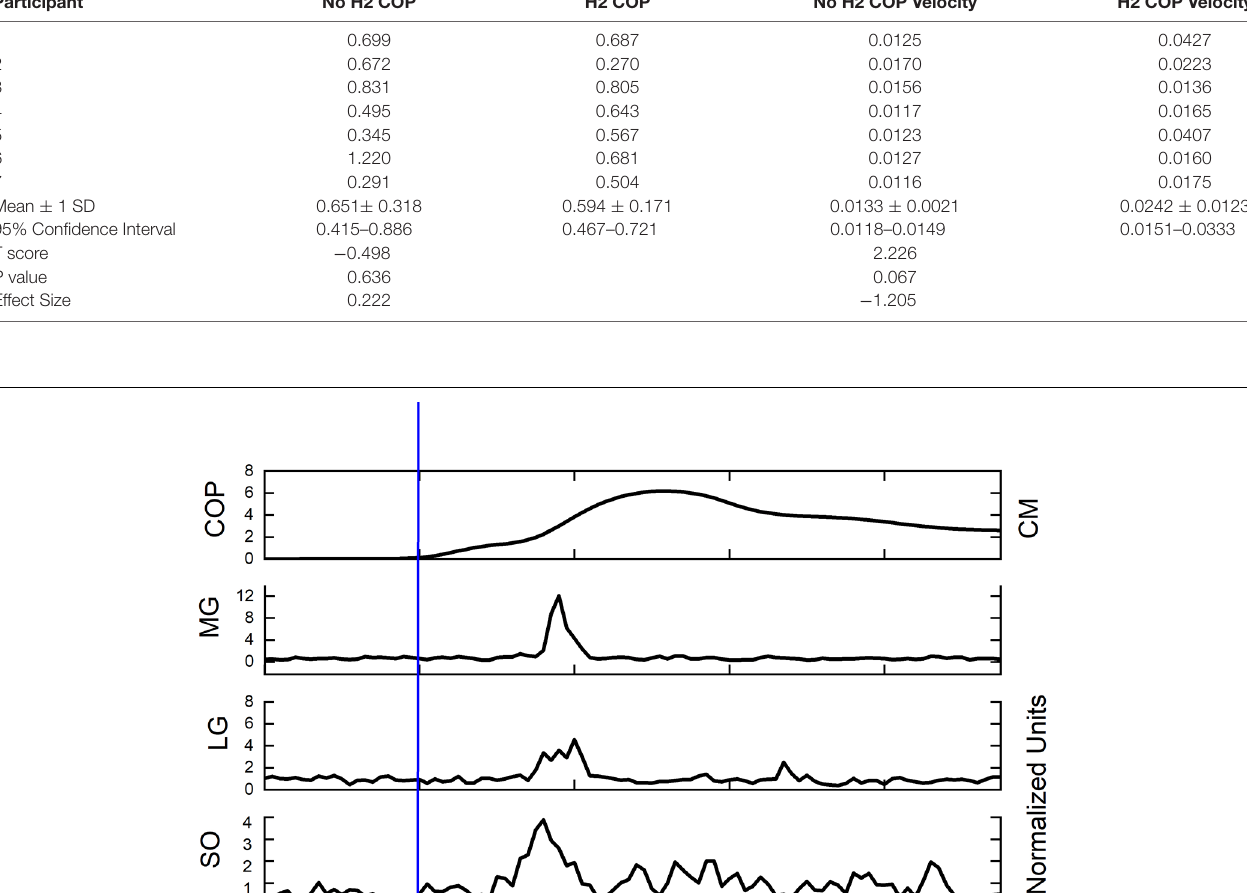
epoch that are significantly different between the H2 and no H2